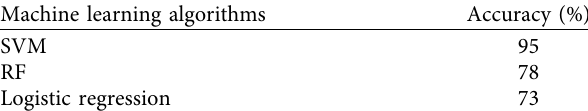
Table 1: Accuracy of machine learning algorithms.